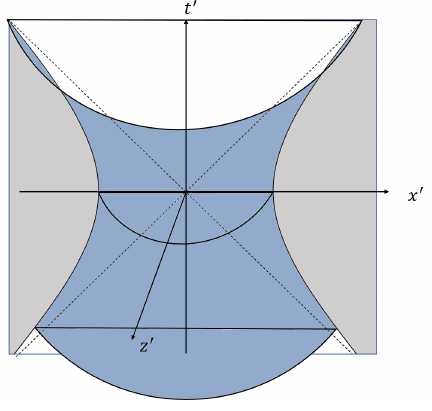
Figure 5 . Holographic dual of a BCFT after the conformal transformation.